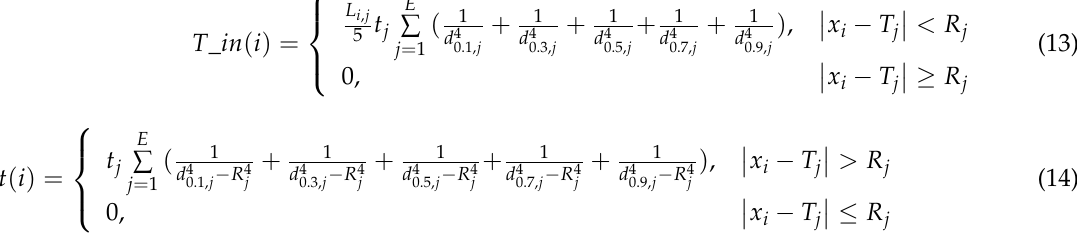
where E represents the number of dangerous areas and t j , T j , and R j are the threat